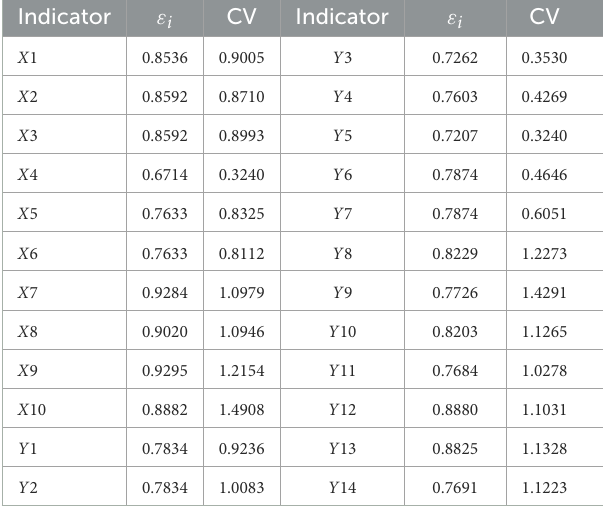
TABLE 2 Average gray rational degree and coefficient of variation of each